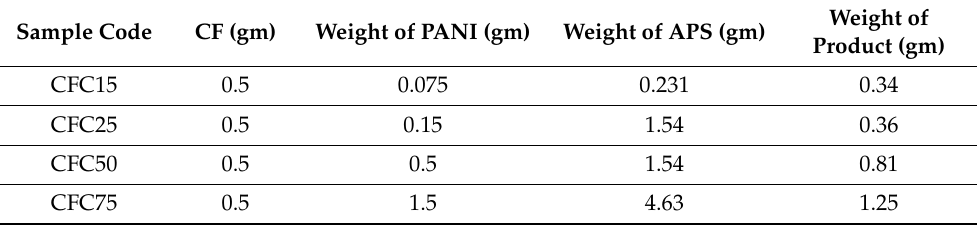
Table 1. Nomenclature and starting weight of the reagents for the preparation of